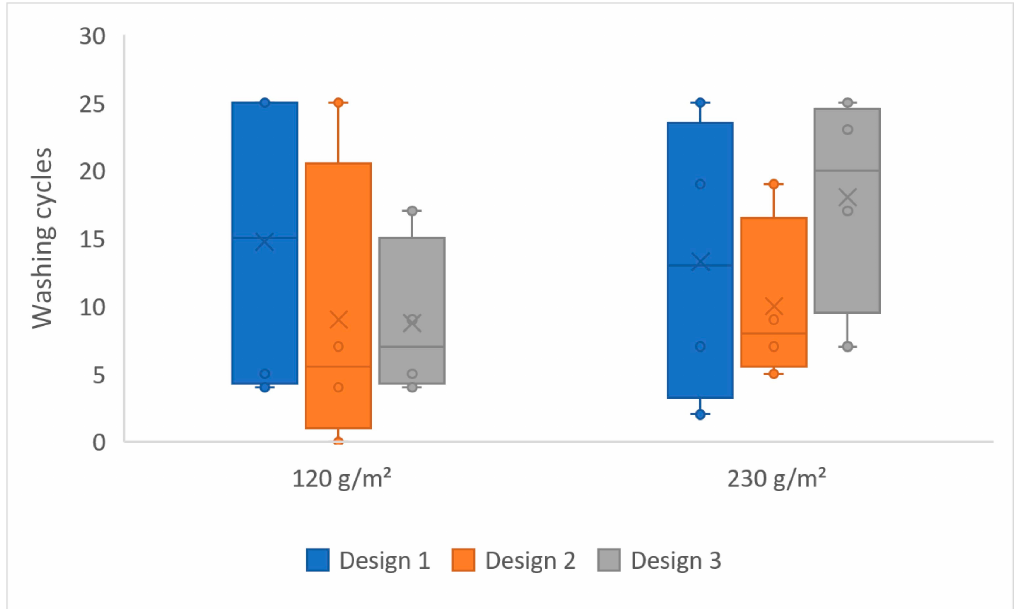
Figure 10. Comparing fabric weight as a parameter for lifetime.